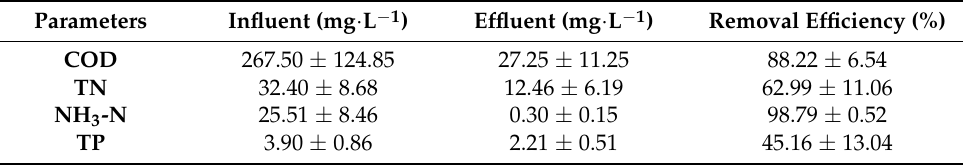
Table 2. The concentrations of influent and effluent, and the removal efficiency of COD, TP, TN, and NH 3 -N in the LEP-N-MBR